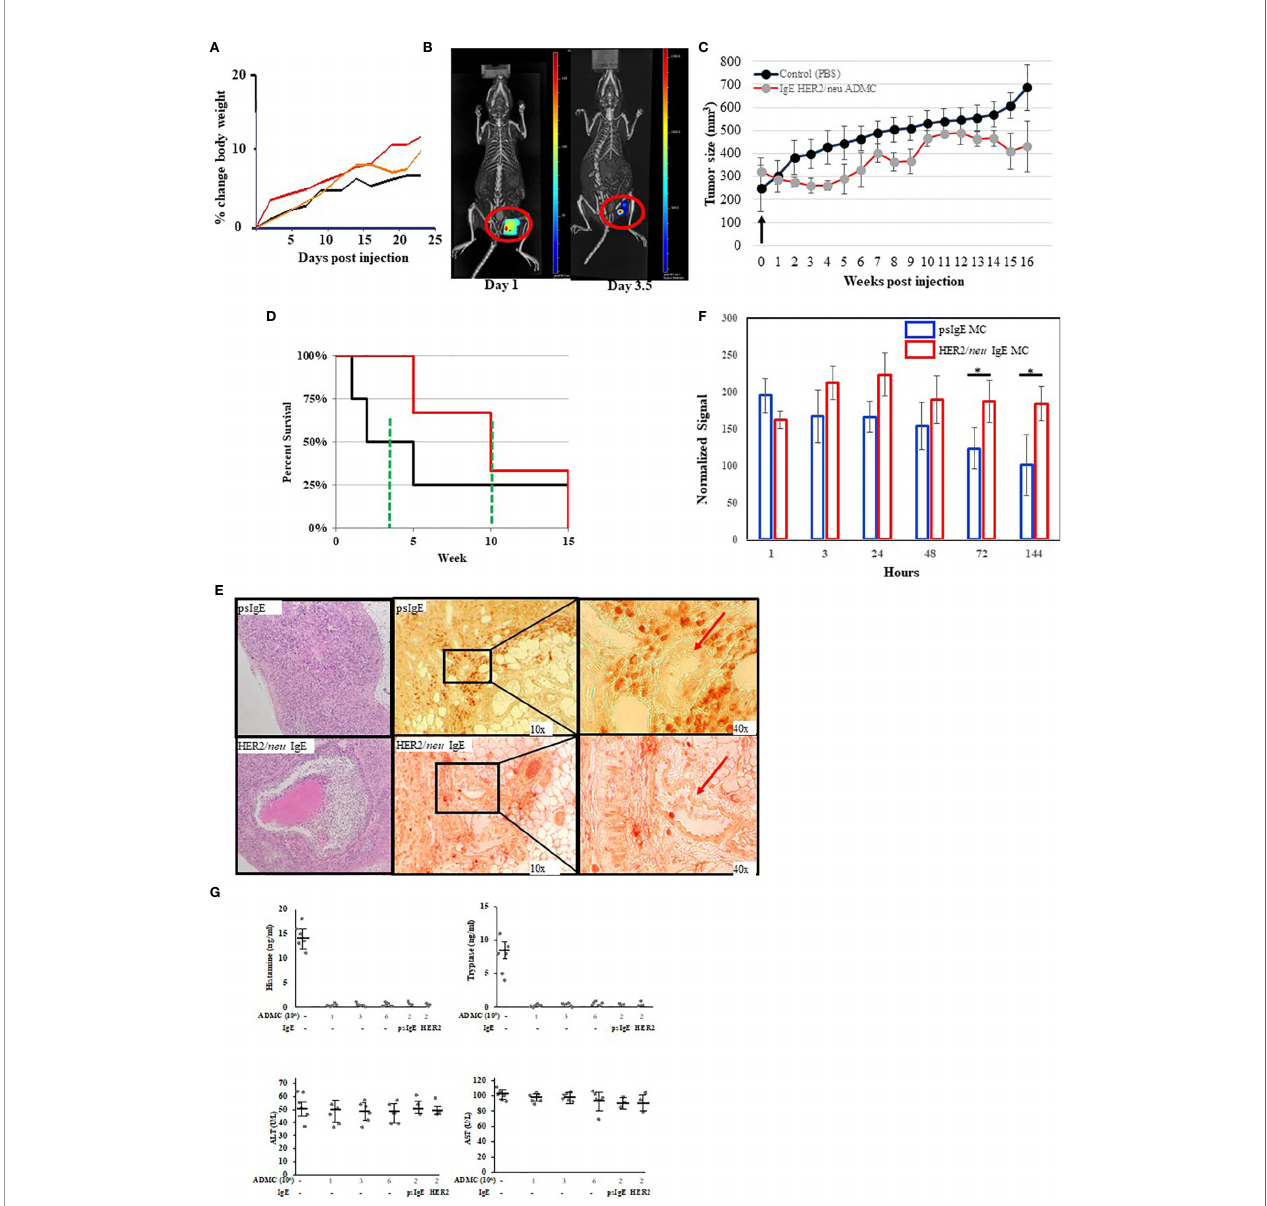
FIGURE 5 | In vivo analysis of ADMC. (A) Maximum tolerated dose of ADMC in vivo. NU/NU mice (female; 8-week-old; 5 per group) injected i.v. with 1x10 6 (black), 3x10 6 (orange), or 6x10 6 (red) ADMC and mouse weights analyzed over time shown. No signi fi cant loss in body weight was observed to indicate toxicity. (B – D) . Tumor binding and anti-tumor activity of ADMC in vivo. Tumors were prepared by injecting Nu/Nu mice with 2x10 6 HER2/ neu + BT474-1261 cells. Mice were injected i.t. with 1x10 6 HER2/ neu (B) monitored over 7 days using 3D fl uorescence imaging with an IVIS-Spectrum imaging system, followed immediately by a CT imaging using an in vivo microCT imaging system. (C, D) Antitumor activity of ADMC in HER2/ neu positive human BC tumors in Nu/Nu immunocompromised mice. Tumors were prepared as in (B) . When tumors reached ∽ 200 mm 3 , mice (4/group) were injected i.t. with or without (PBS), HER2/ neu or psIgE sensitized ADMC (2x10 6 ) at day 0 and tumor volume (C) and mean survival (D) assessed. Points, mean tumor volume (mm 3 ); bars, ±SD. The green line represents the mean survival for each group. (E) Tumors obtained from mice treated as above (day 4) were incubated with H&E (left), mouse anti-human tryptase (middle), or MOPC ( Supplementary Figure 2 ) followed by peroxidase anti-mouse Abs. Red arrows are blood vessels. HER2/ neu IgE-sensitized ADMC are evenly distributed inside the tumor tissue (bottom), while psIgE-sensitized ADMC are sparse inside the tumor tissue (top) and are mostly found in close vicinity of blood vessels, where they fl ow into the blood stream. (F) Quanti fi cation of ADMC numbers was assessed by monitoring the fl uorescence of the CellBrite signal in the tumors in vivo over time. Data are represented as the mean ± s.e.m. of n = 3 technical replicates. *P < 0.05. (G) Cytotoxic human MCs do not induce systemic MC release or toxicity. NU/NU mice (no tumors) were injected i.v. with indicated numbers of ADMC. Serum was collected at 1 hour (histamine and tryptase) or after 8 weeks (ALT/AST) and assessed for each mediator using commercially available kits. In last 2 points comparing psIgE vs HER2/ neu IgE sensitized ADMC injected mice had established (>200 mm 3 ) HER2/ neu -positive tumors as above. Spiked mouse serums were used as controls for histamine and tryptase. Data are represented as mean ± s.e.m. No statistical signi fi cance change in serum levels was observed using ANOVA between non-ADMC treated animals vs